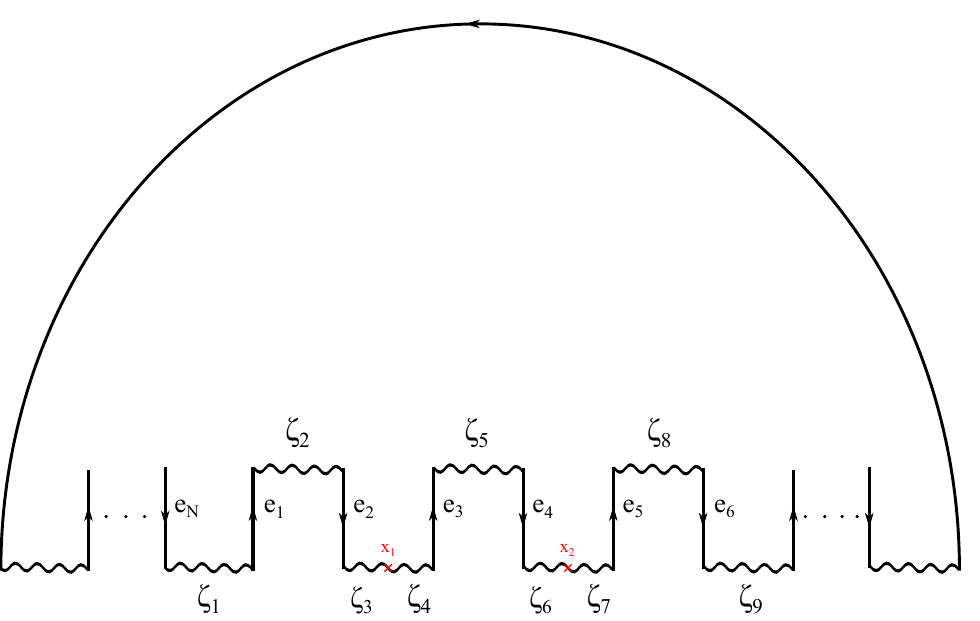
Figure 5 . This (cid:12)gure is an example of a type A n bow with edges f e I g , segments f (cid:16) i g , and marked points f x n g